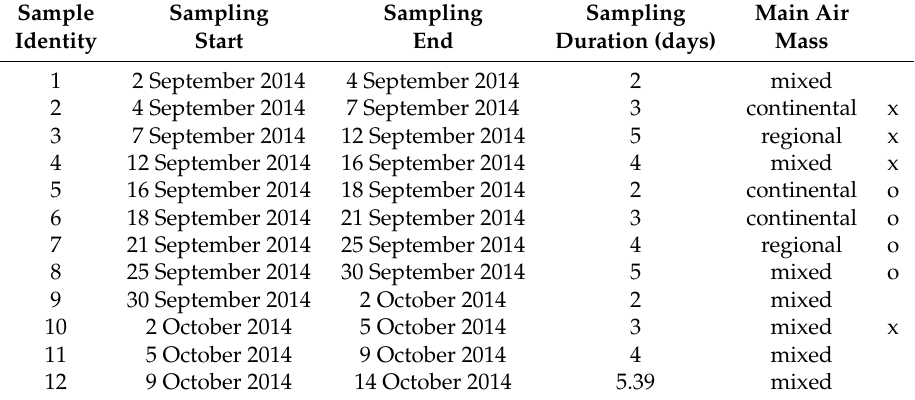
Table 1. Filter samples taken and analyzed by CIO; marked with an o are samples used for a comparison of carbon concentrations with 24-h filter samples from TNO and marked with an x are samples analyzed additionally by two other laboratories (LARA and LABEC) for an inter-comparison of F 14 C of EC. Sample Sampling Sampling Sampling Main Air Identity Start End Duration